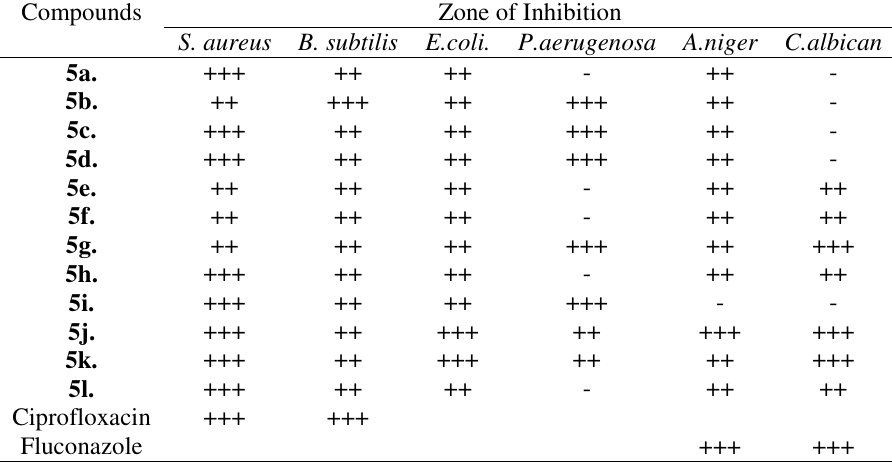
Table 3. Results of antimicrobial